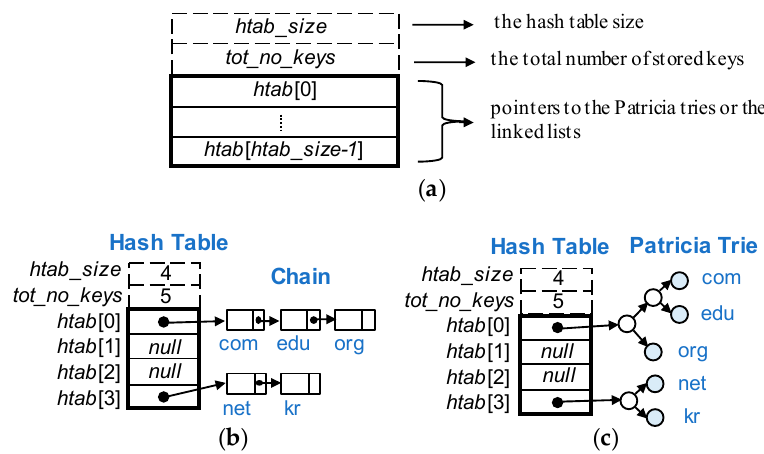
Figure 5. The structure of the hash table and two types of hashing schemes: ( a ) hash table format, ( b ) separate chaining, and ( c ) Patricia trie-based.